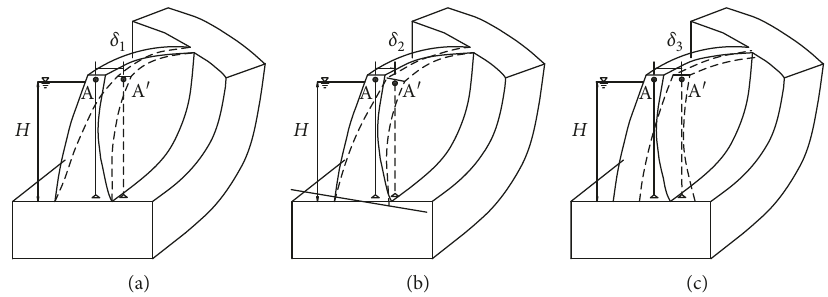
Figure 2: Three parts of the displacement component under water